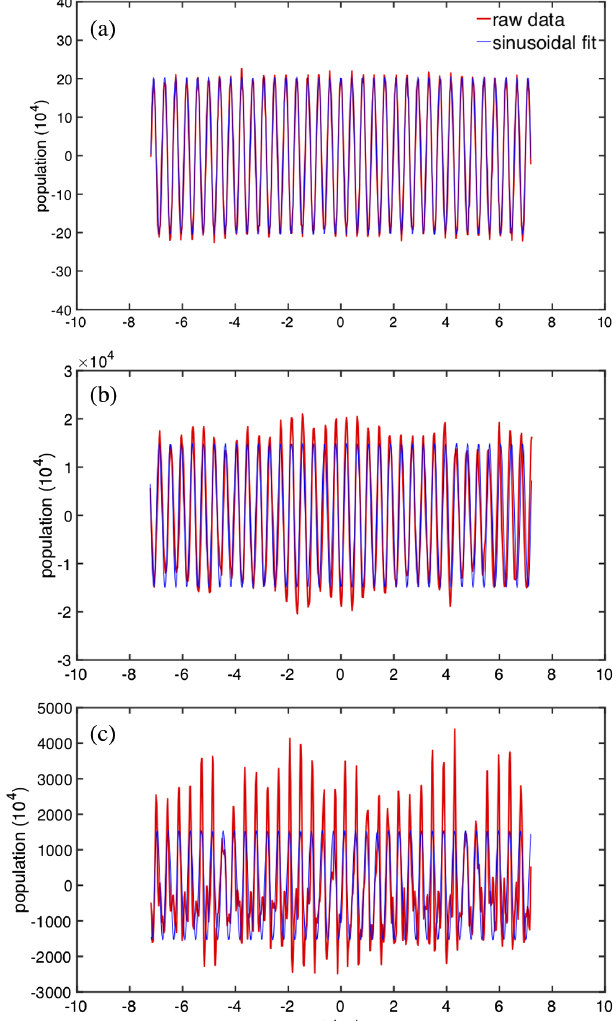
FIG. 10. Particle density distribution along the bunch at (a) s ¼ 0 m, the initial location, (b) s ¼ 93 m, where the maximum gain locates, and (c) s ¼ 97 m, the exit of the beamline. The initial modulation wavelength is assumed 125 μ m. Only the steady-state CSR is included in the calculation. The red lines are from the histogram of simulation data (raw data), the blue lines from sinusoidal